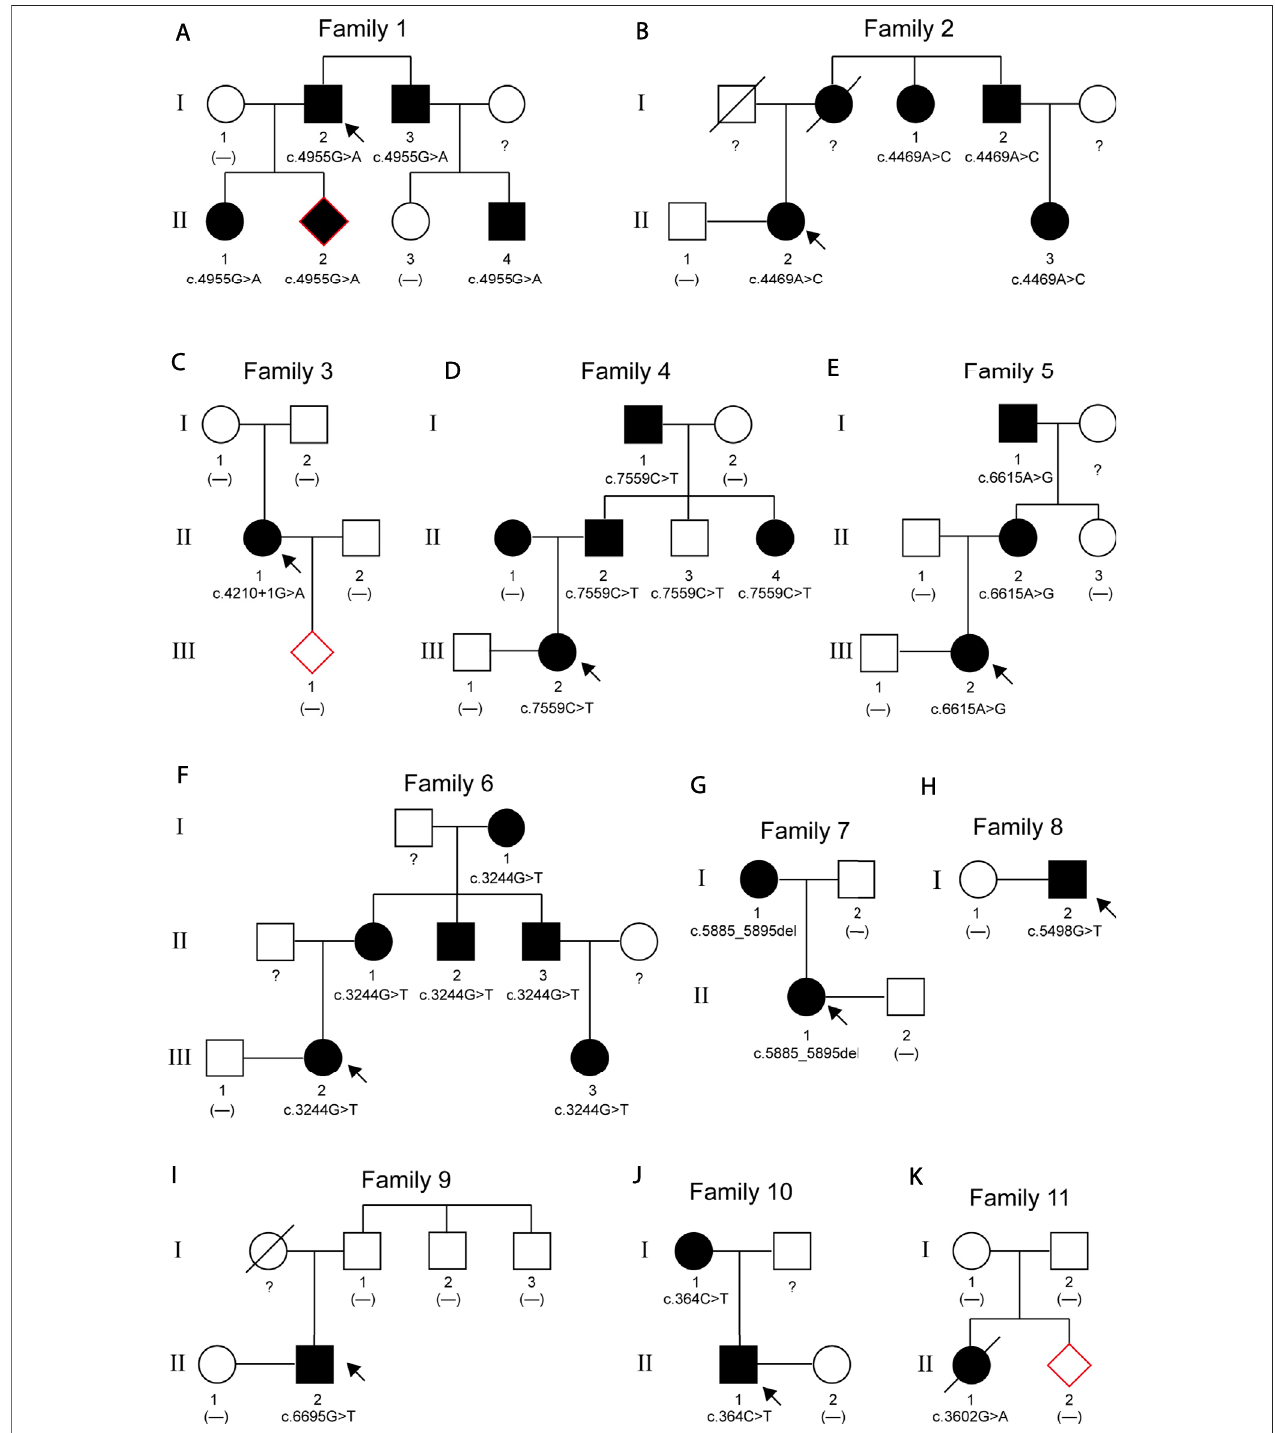
FIGURE 2 | Pedigrees of 11 families with MFS. The arrows indicate the proband of each family. Squares represent males; circles represent females; solid symbols indicate affected patients; open symbols indicate unaffected subjects; a slash through the symbol means deceased.